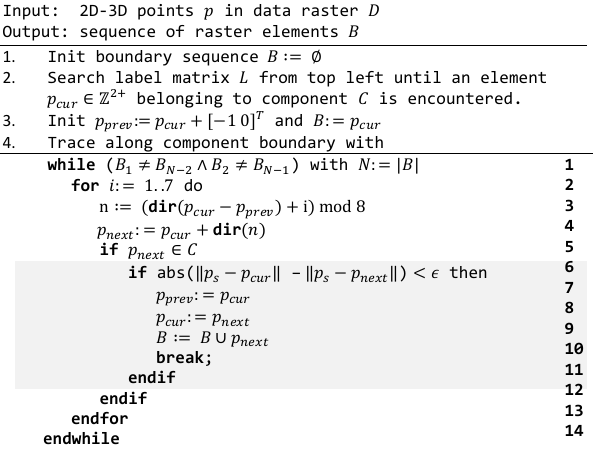
Algorithm 4. Boundary tracing with depth discontinuities. The gray highlighted part marks our extension. dir denotes the encoding of the direction vector in 8-adjacency as an integer and vice versa.